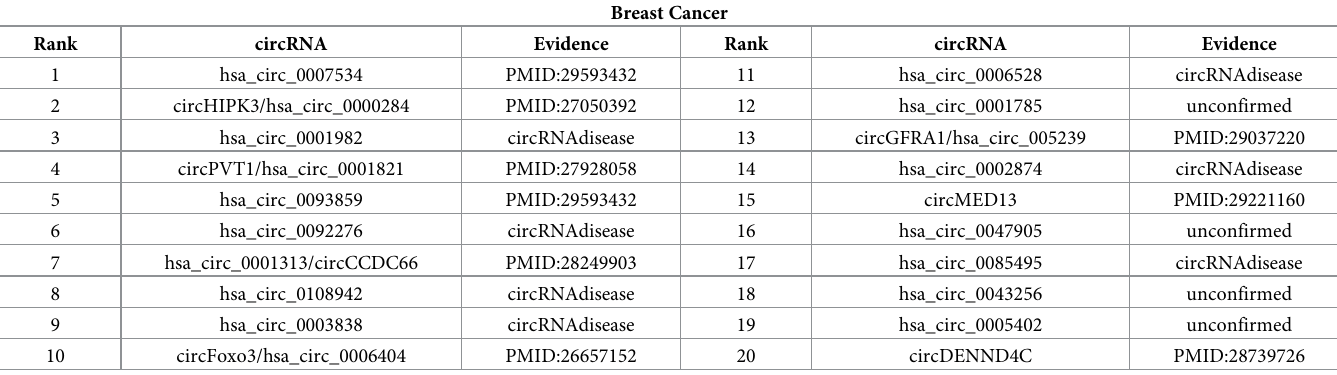
Table 5. The top 20 breast cancer related candidate